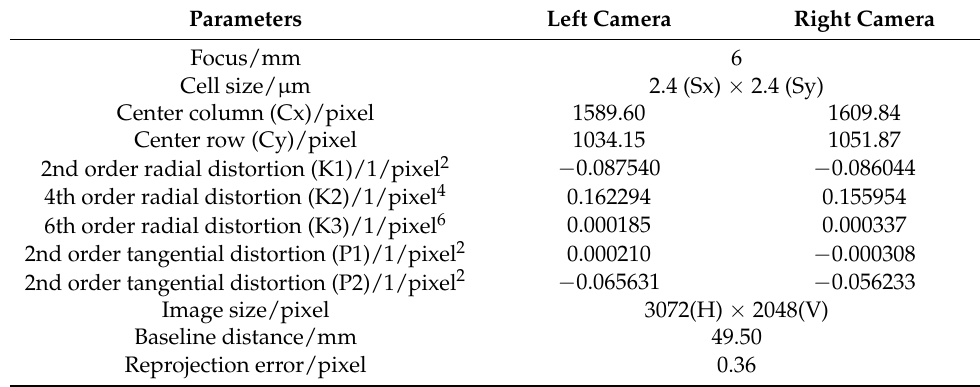
Table 2. The internal and external parameters of the binocular stereo vision system.